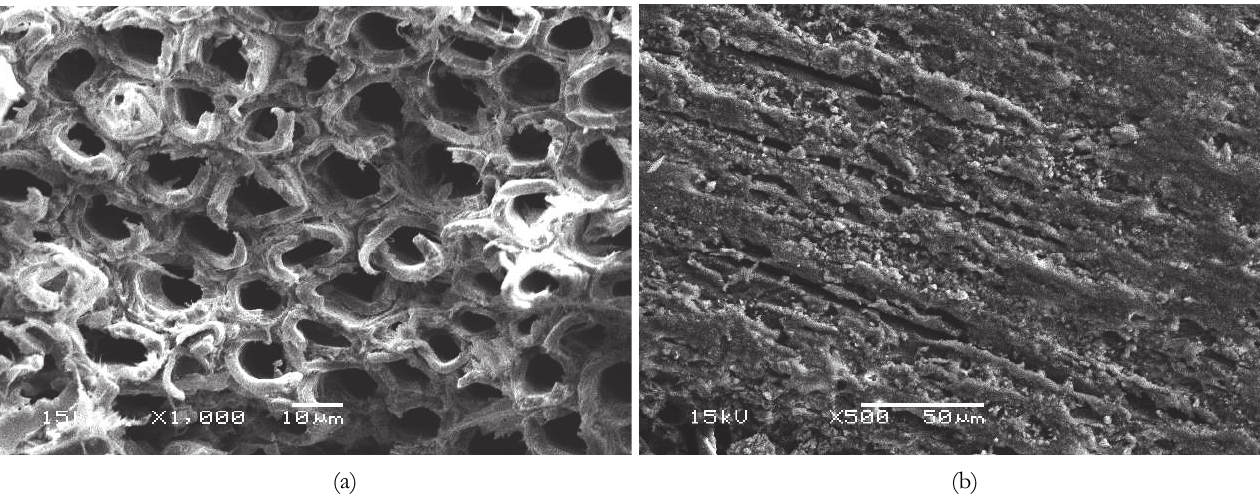
Figure 8: Date palm fiber mesh scanning electron microscope observations: (a) cross section and (b) exterior surface.